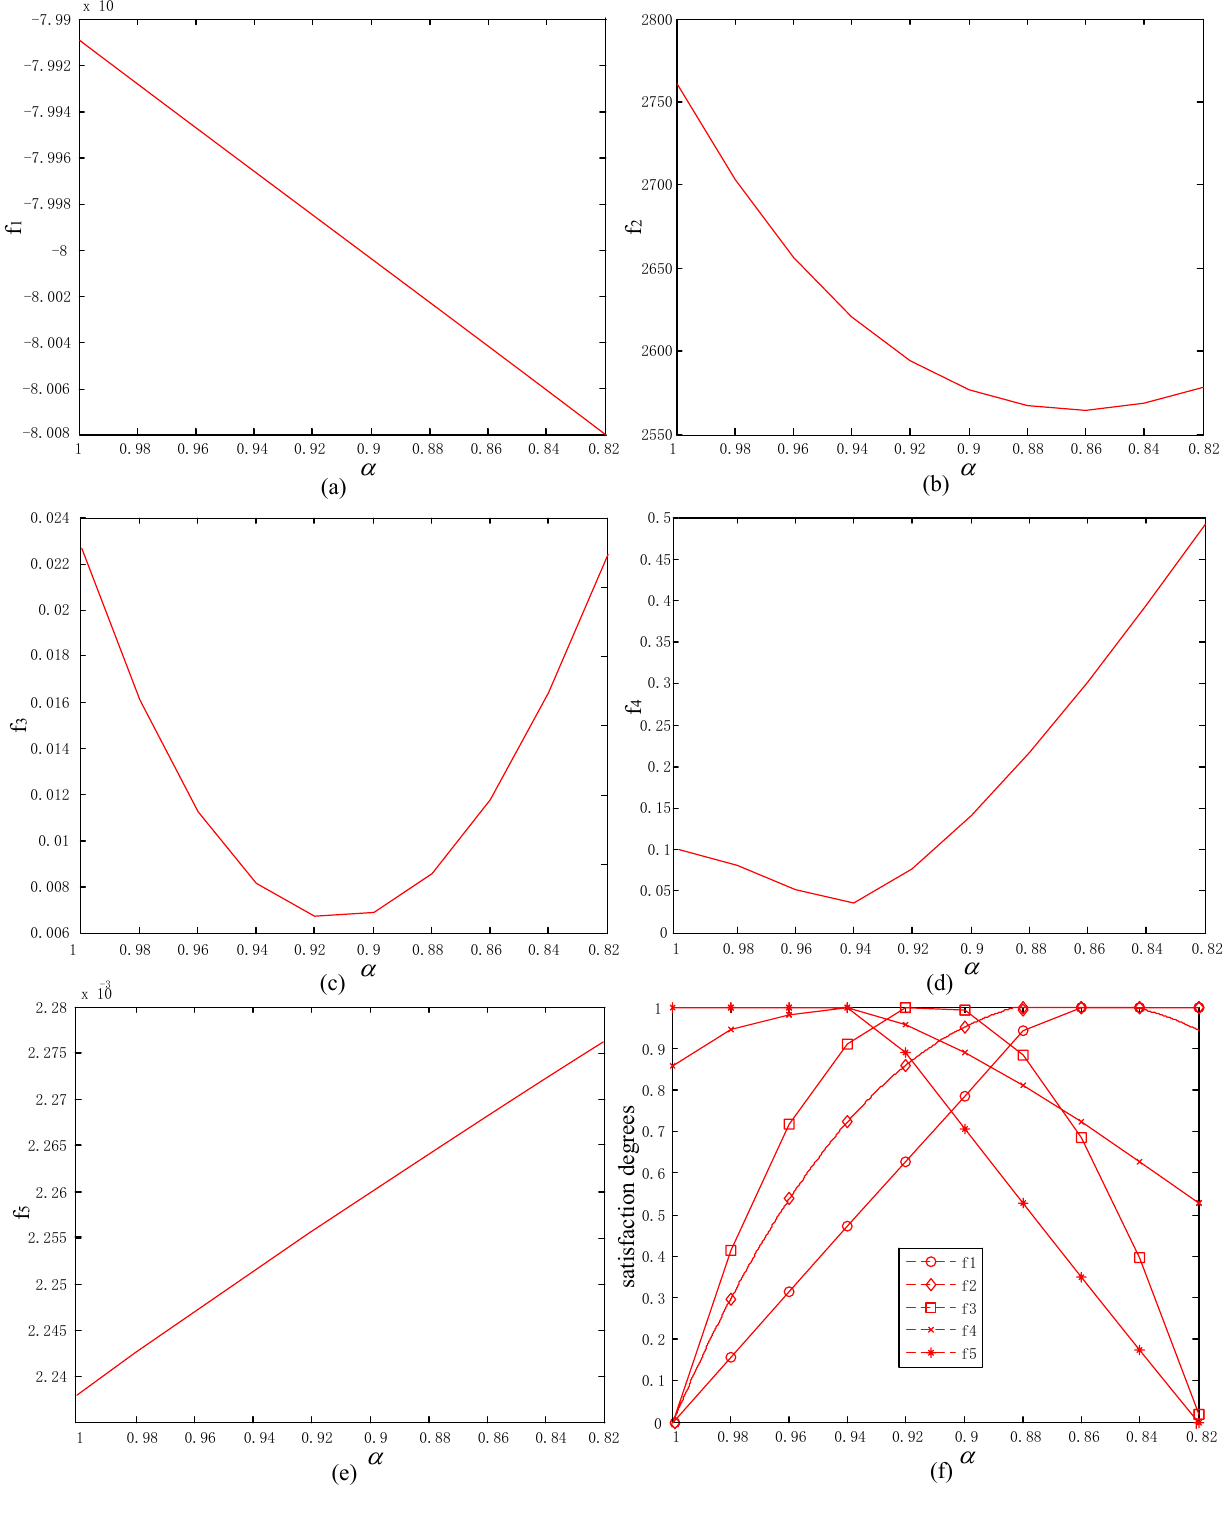
Figure 8. ( a ) Goal value of the objective f /W; ( c ) Goal value of the objective f f 2 the objective f ; ( f ) Satisfaction degrees of the fi ve 5